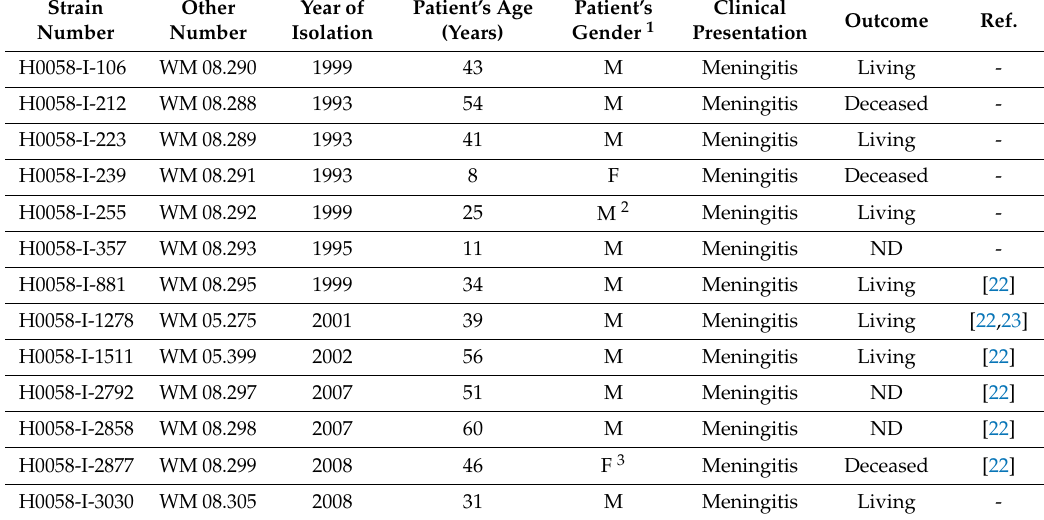
Table 1. General information of clinical Cryptococcus gattii VGII isolates from Cucuta, Colombia. Strain Other Year of Patient’s Age Patient’s Clinical Outcome Number Number Isolation (Years) Gender 1 Presentation